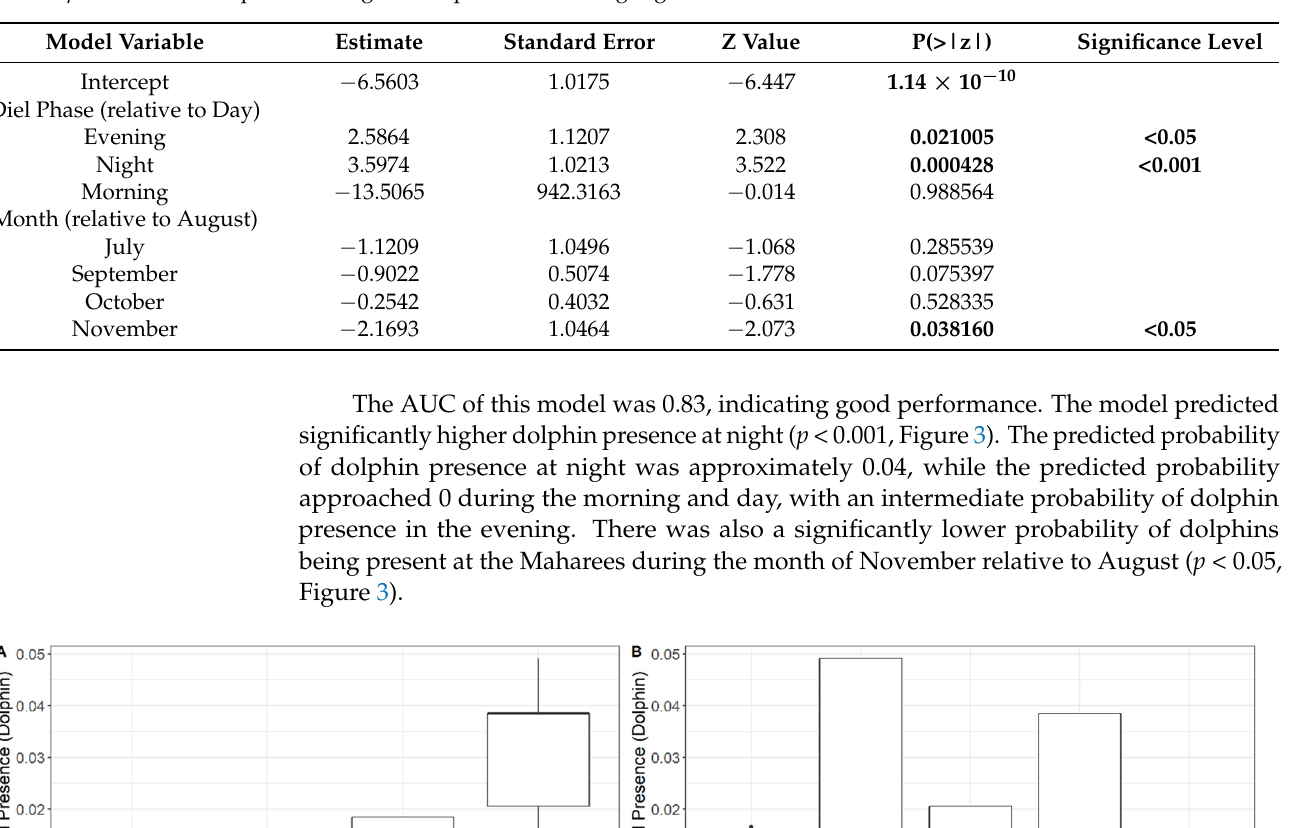
Table 3. Binomial GLM output (dolphin presence at the Maharees). The output shows the estimate, standard error, z value and p -values for each predictor. Significant predictors are highlighted in bold.